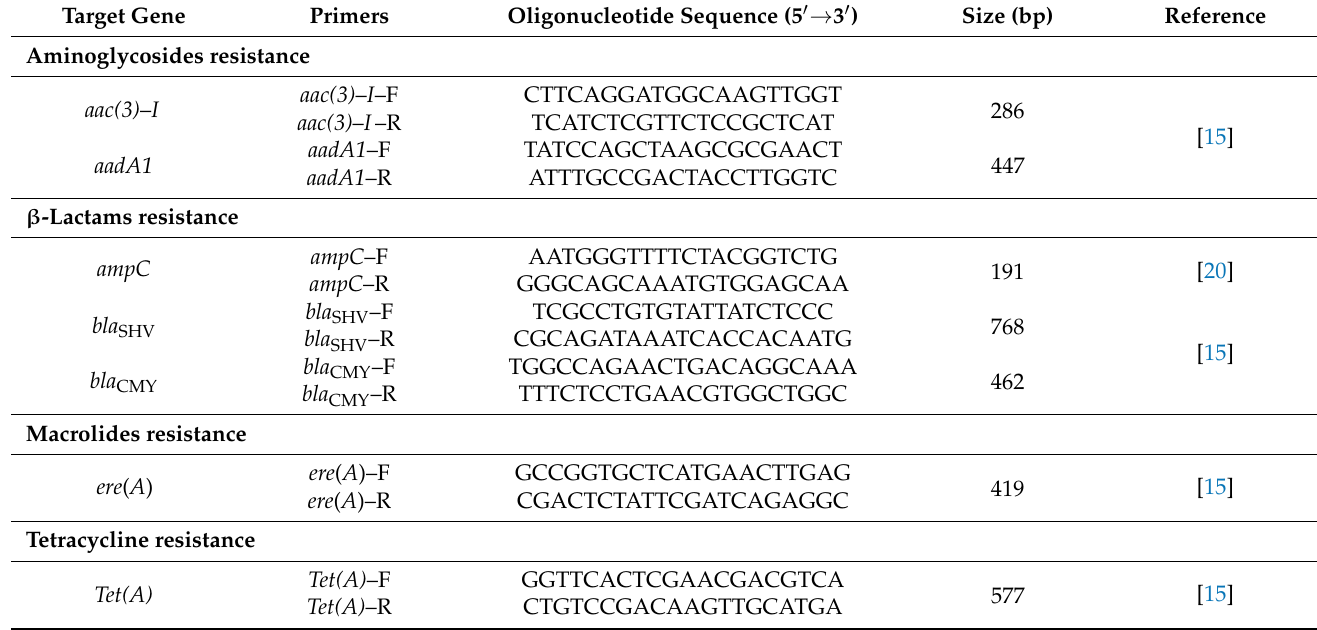
Table 2. List of DNA oligonucleotides used in this study for PCR